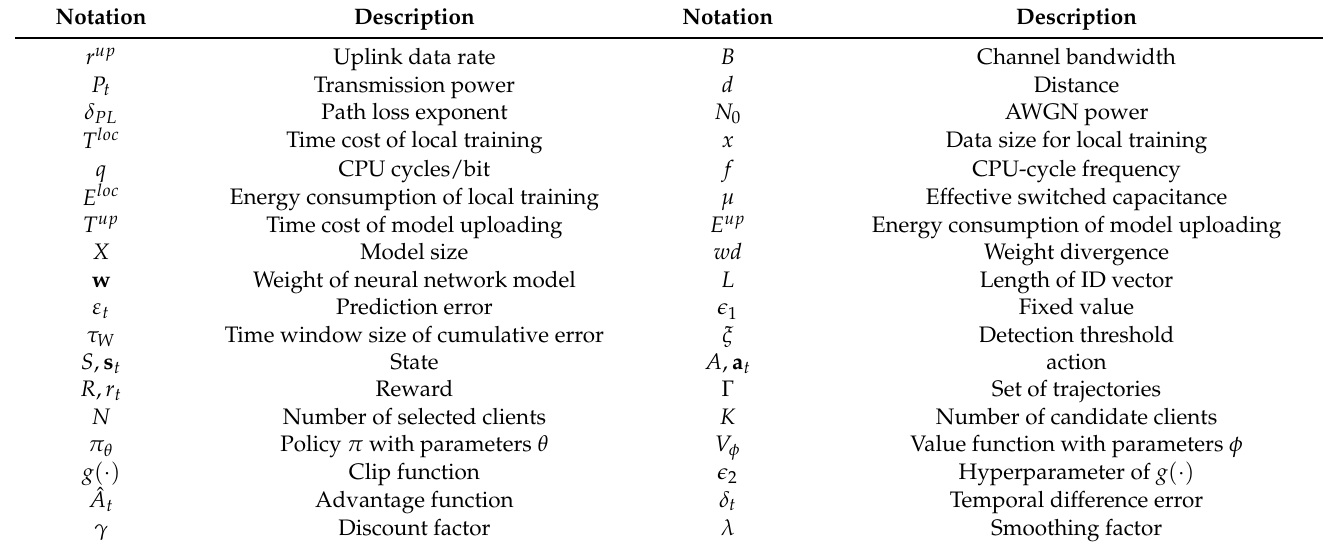
Table 1. Summary of